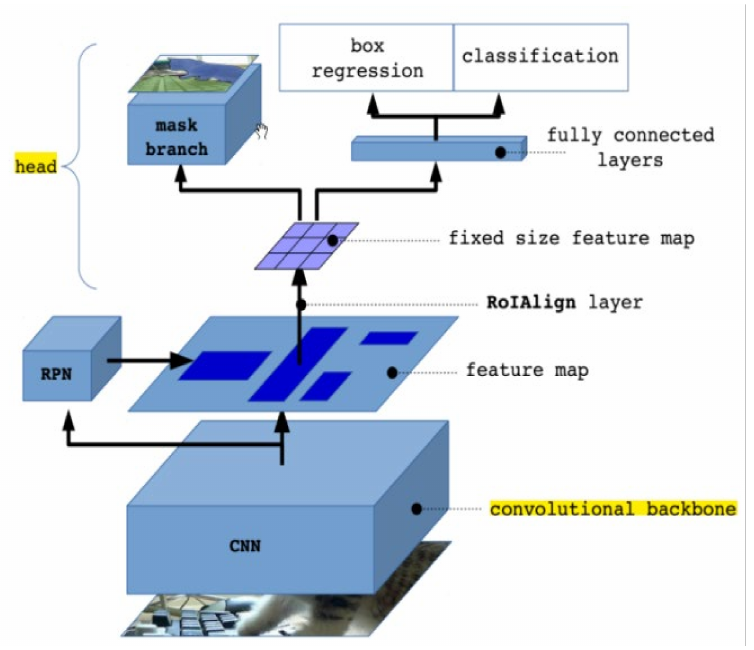
Figure 15. Training